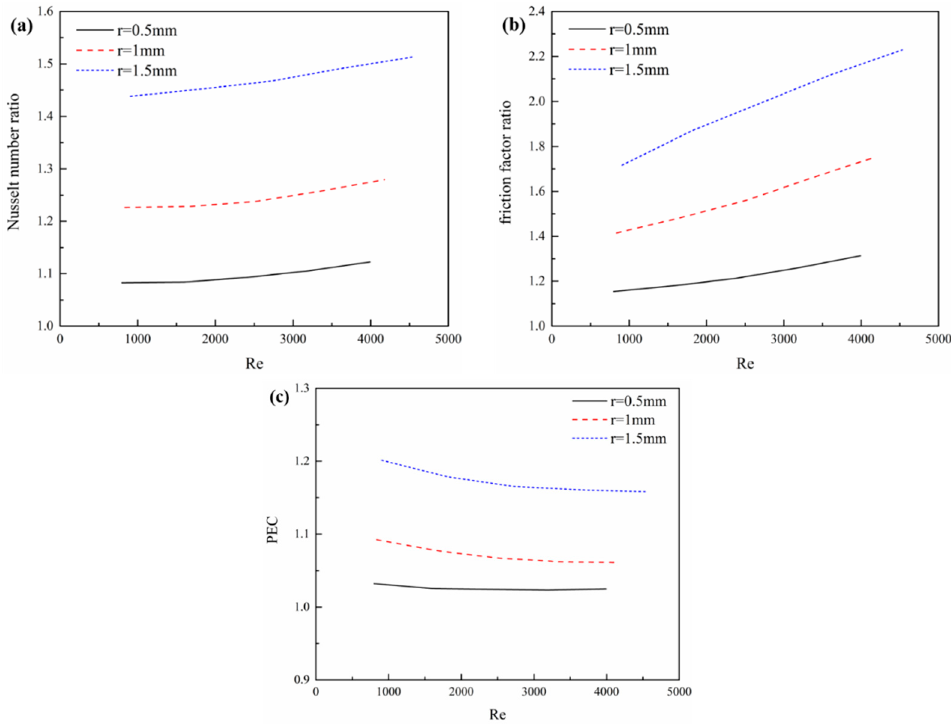
Figure 5. Influence of different perforated diameter on heat transfer performance with Reynolds number. ( a ) Nusselt number ratio; ( b ) friction factor ratio; ( c ) the performance evaluation criteria (PEC).